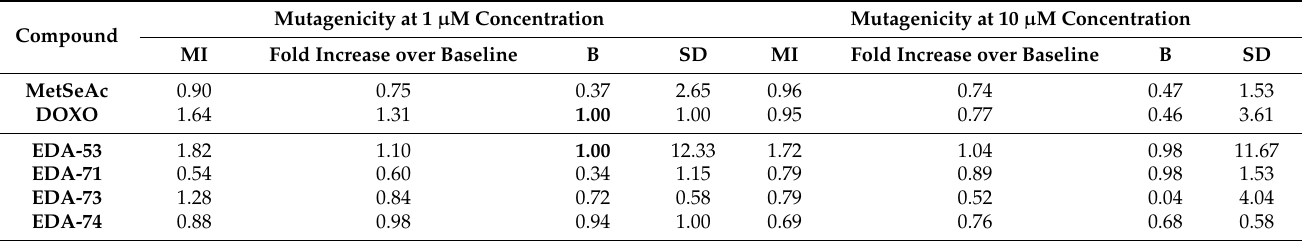
Table 4. Mutagenic index (MI) and other values for methylseleninic acid (reference Se compound), doxorubicin (reference anticancer agent), and tested derivatives with high cytostatic activity.